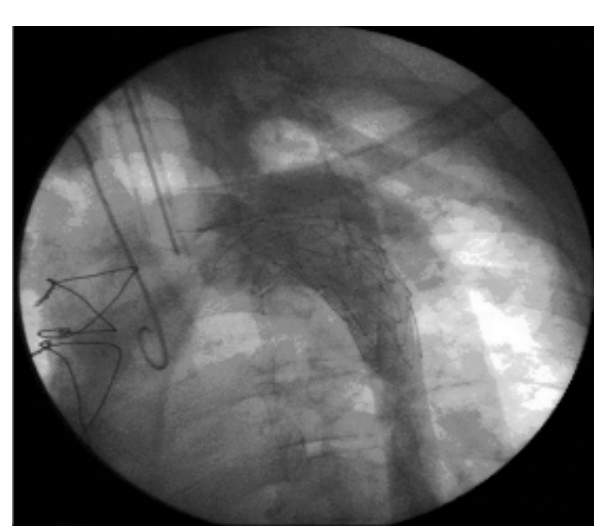
Fig. 2 – Aortografia realizada após correção cirúrgica da dissecção mostra troca valvar aórtica com colocação de prótese biológica de pericárdio bovino, prótese tubular em aorta ascendente normal e implante de sistema endovascular auto-expansível via femoral (stent) em dissecção de aorta torácica descendente sem shunts